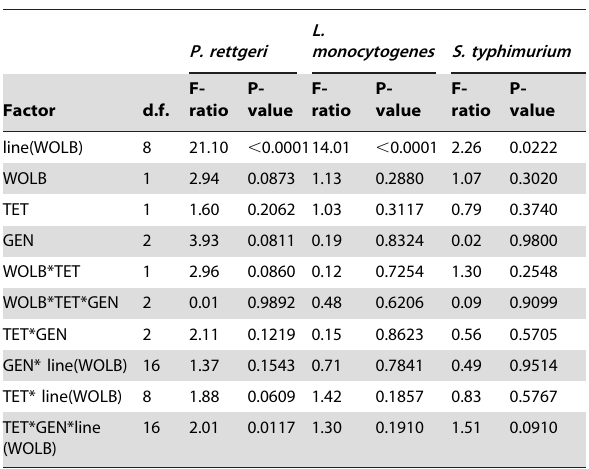
Table 3. Analyses of variance relating fixed effects of genotype, Wolbachia status, and tetracycline treatment to bacterial load when infected with P. rettgeri 2, 4, and 6 generations after tetracycline treatment.